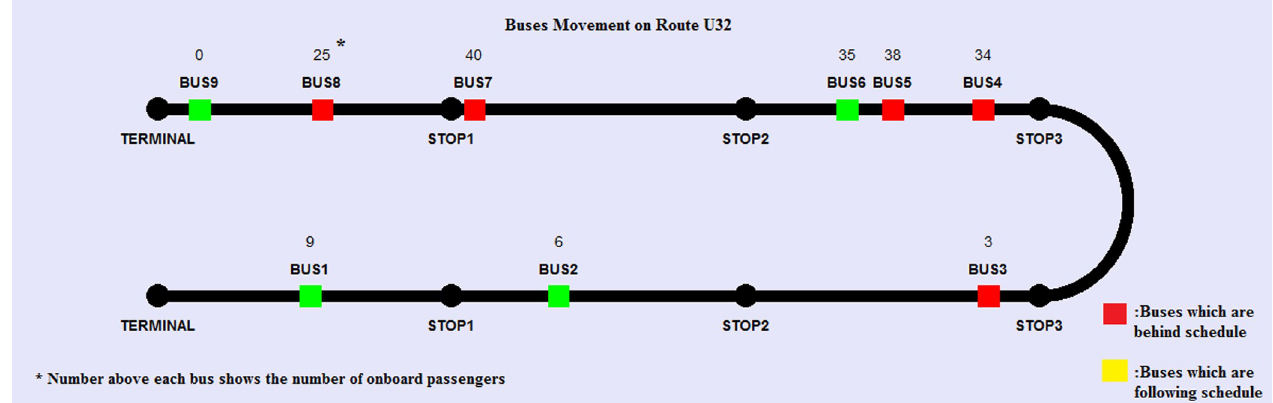
Fig 6. Snapshot of animated playback for verification propose.